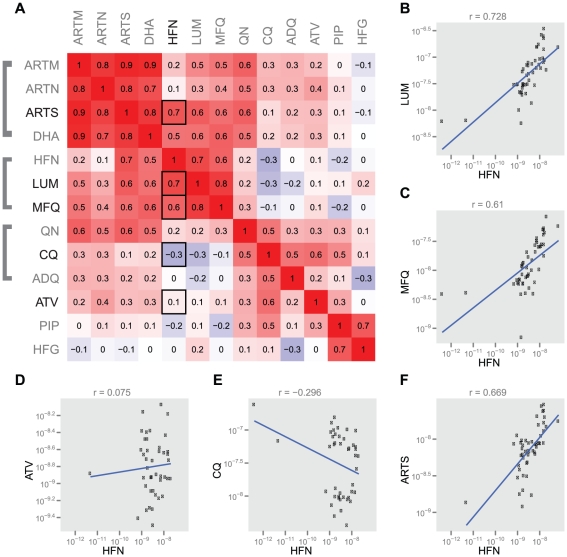
Correlations between antimalarial drugs tested.(A) Pearson correlation values (r) between
log10(IC50) values are rendered as a color in
a symmetric correlation matrix (red: correlated; white-uncorrelated,
blue: inversely correlated). Thirteen antimalarials are measured:
artemether (ARTM), artesunate (ARTN), artemisinin (ARTS),
dihydroartemisinin (DHA), halofantrine (HFN), lumefantrine (LUM),
mefloquine (MFQ), quinine (QN), chloroquine (CQ), amodiaquine (ADQ),
atovaquone (ATV), piperaquine (PIP), and halofuginone (HFG). Drugs are
grouped by structural relatedness. (B–F) Correlation plots are
given with a linear regression line for HFN compared to the 5 other
drugs tested for antimalarial resistance with PF10_0355
overexpression: (B) LUM, (C) MFQ, (D) ATV, (E) CQ, and (F) ARTS.